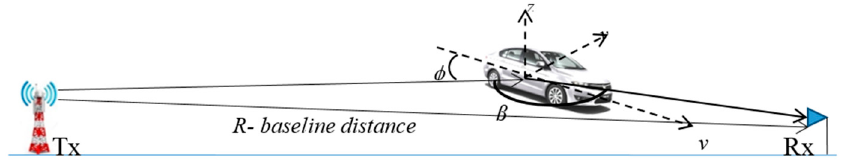
Figure 1. Topology of passive forward scatter radar setup showing wave incident angle, φ .